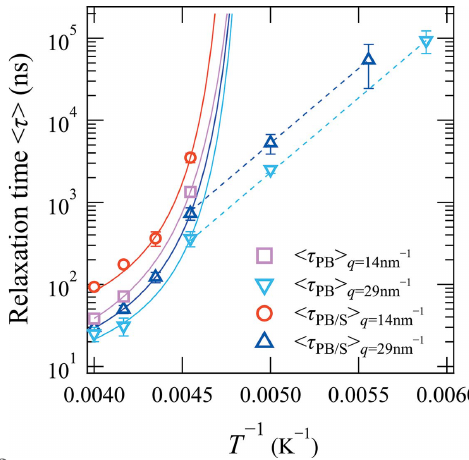
Figure 3 Temperature dependence of the mean relaxation times h (cid:3) i of the non- crosslinked and crosslinked PB samples in their unstretched states where q = 14 nm (cid:2) 1 (magenta squares, red circles) and 29 nm (cid:2) 1 (cyan down- triangles, blue up-triangles). The solid curves represent the results of fitting the data to the Vogel–Fulcher–Tammann equation, while the dashed lines represent the results of fitting the data to the Arrhenius equation, in which the activation energy of the JG (cid:5) -process for the non- crosslinked PB ( E a ) is 35 kJ mol (cid:2) 1 .